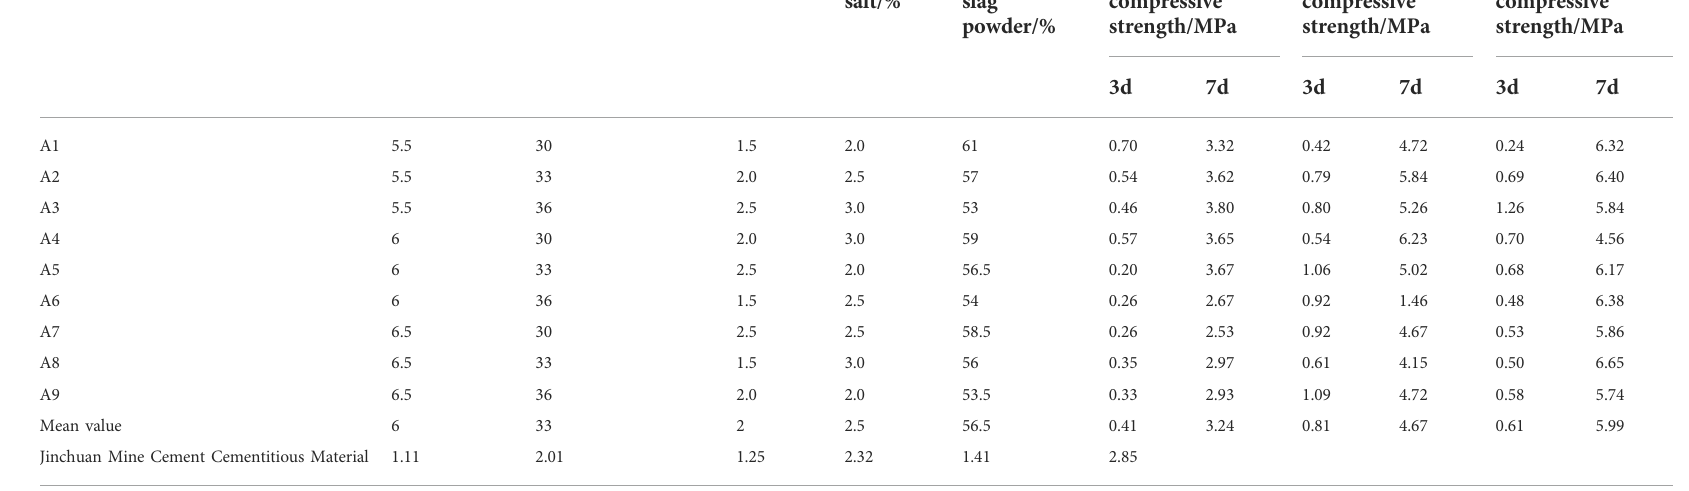
TABLE 1 Orthogonal test results of fi lling body